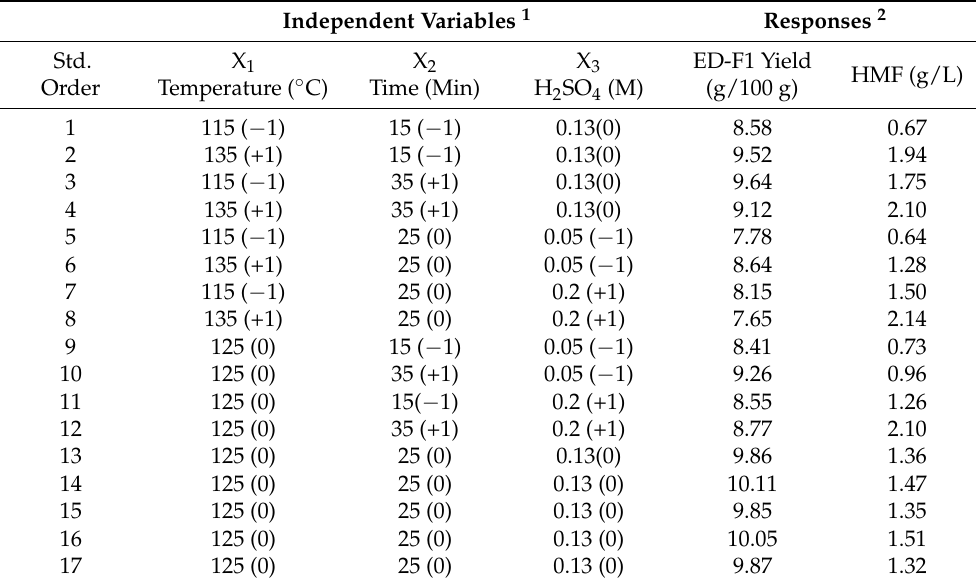
Table 1. Box–Behnken experimental design layout and observed responses of oligosaccharide fraction yield (ED-F1) and HMF by-product.